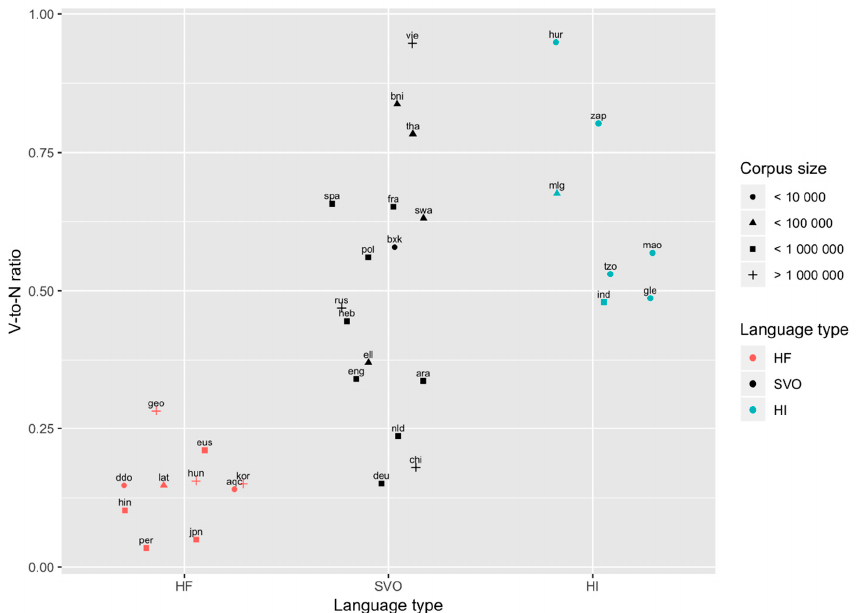
Figure 3. Verb-to-noun ratio by language type (HF, head-final; HI, head-initial; SVO, subject-verb-object). Three-letter language codes are given according to the ISO codes. Corpus size is indicated with the dot shape.